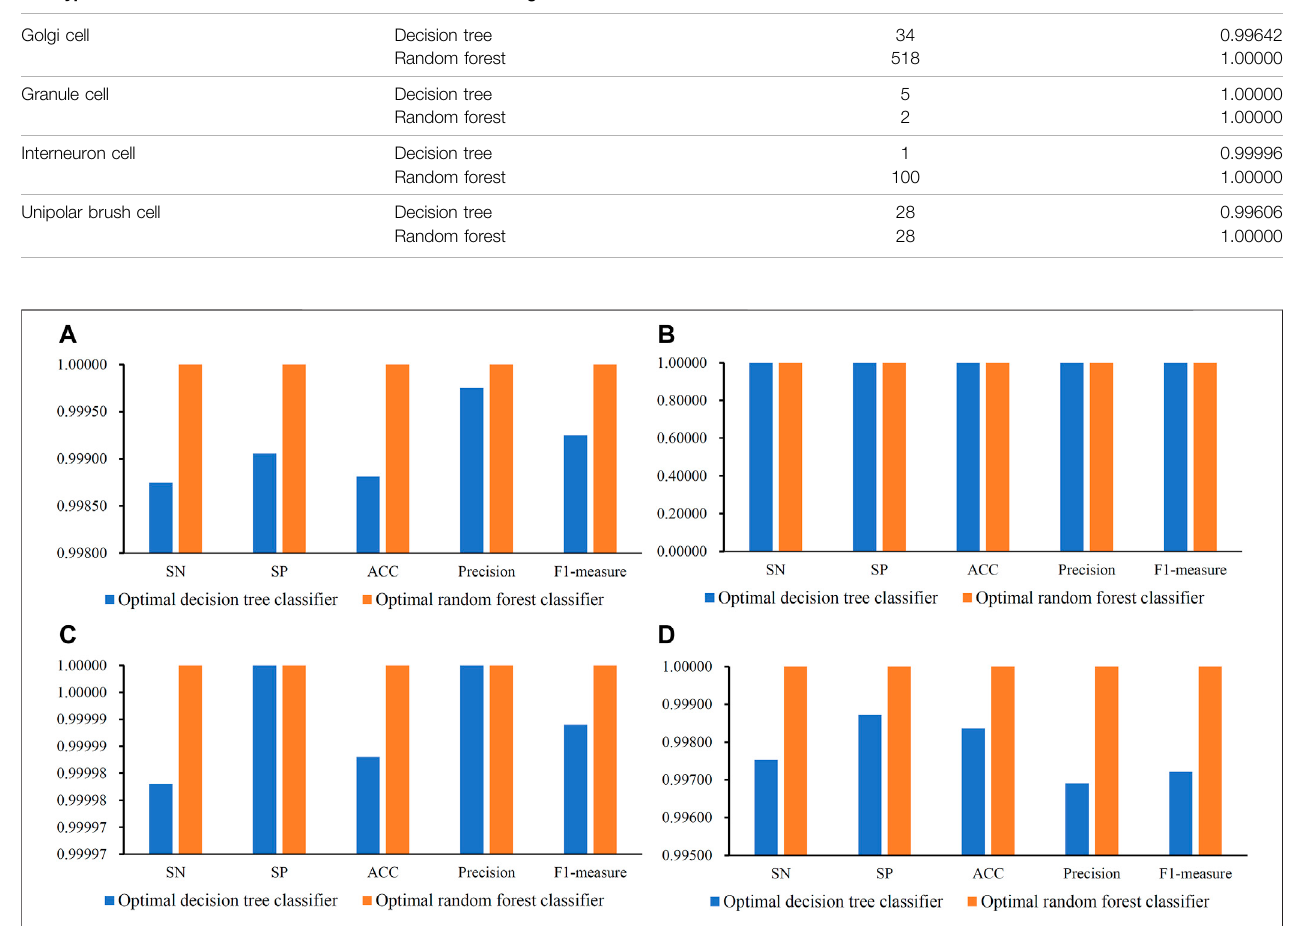
FIGURE3| Somemeasurementsoftheoptimaldecisiontreeandrandomforestclassi fi ersondatasetsoffourcerebellumcelltypes. (A) Measurementsondataset for Granule cells, (B) Measurements on datasets for Granule cells, (C) Measurements on datasets for Interneuron cells, (D) Measurements on datasets for Unipolar brush